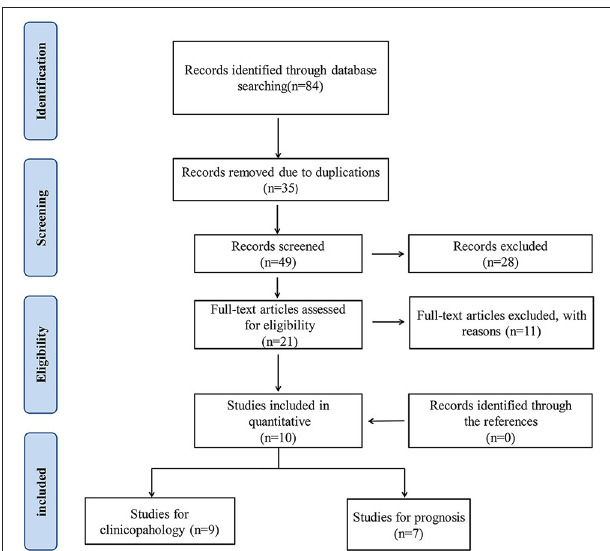
FIGURE 1 | Flow diagram of study search and selection